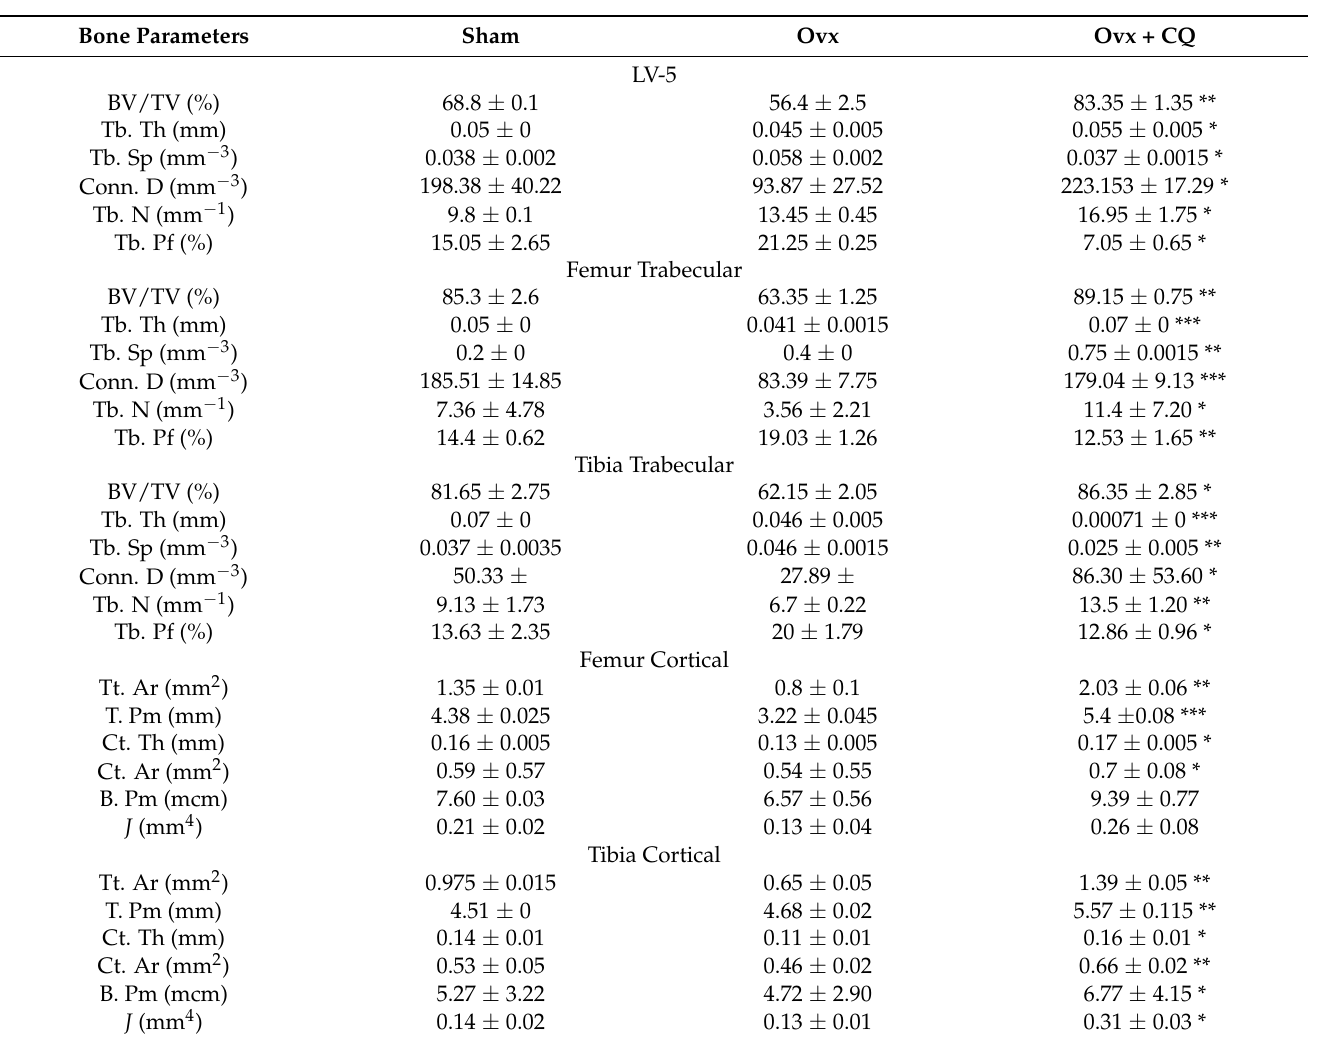
Table 1. Bone histomorphometric indices.